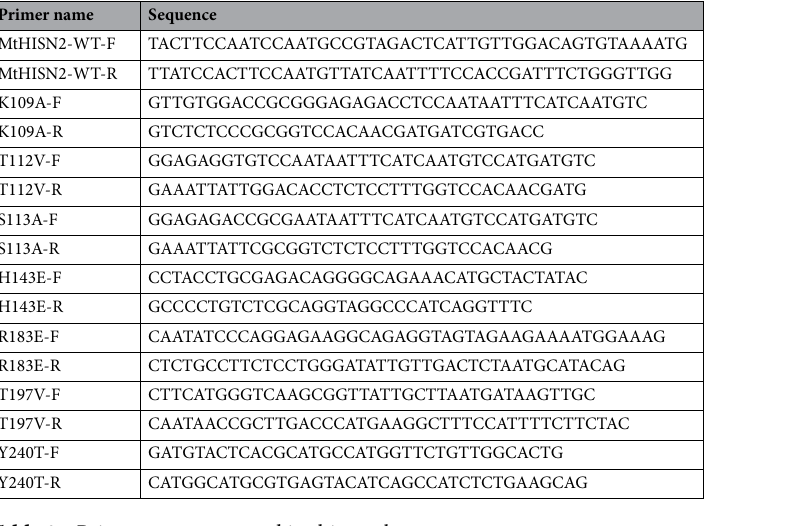
Table 2. Primer sequences used in this